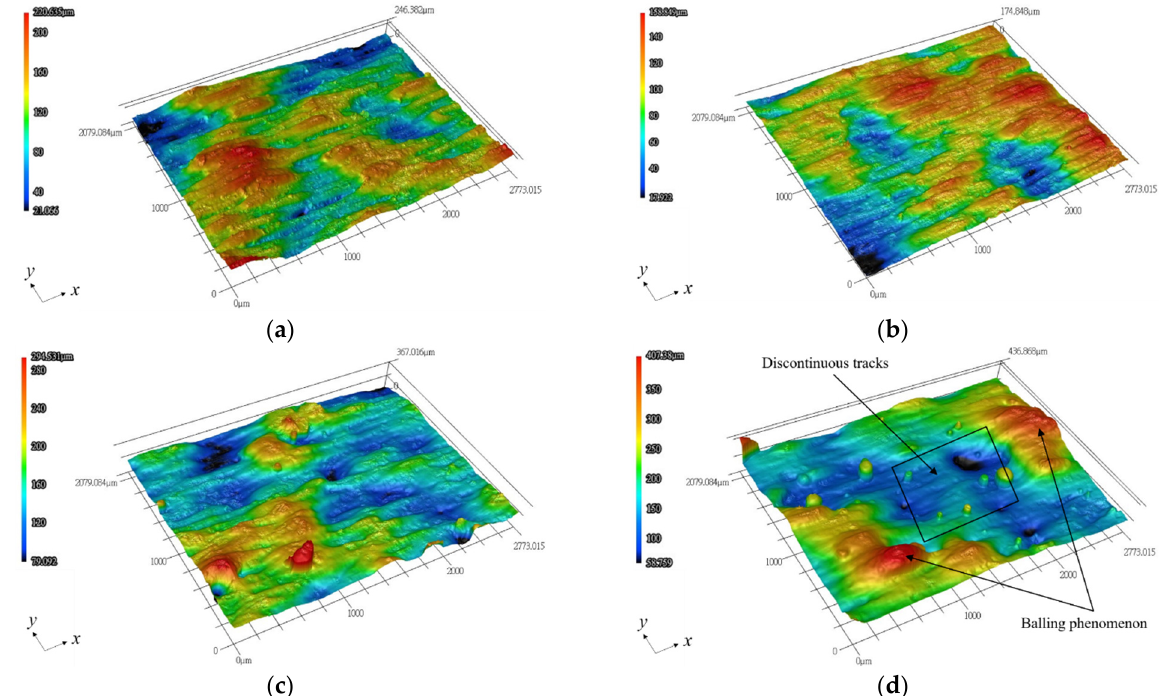
Figure 2. Representative 3D profiles of the top surface, measured by a laser scanning confocal microscope: ( a ) S1; ( b ) S2; ( c ) S3; ( d )